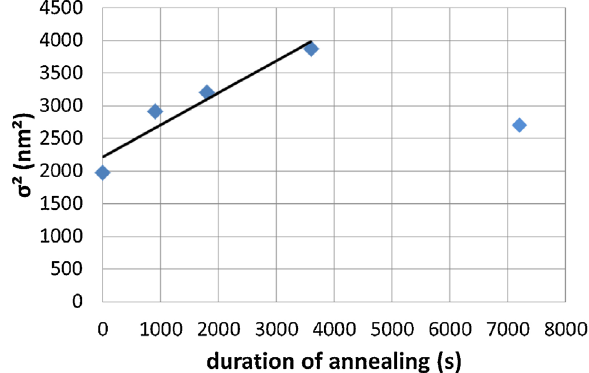
Fig. 8. 3 He pro fi les in B 4 C analysed by NRA with deuteron energy of 1300 keV. Samples were annealed at 900 ° C for different durations (s) before the analysis.